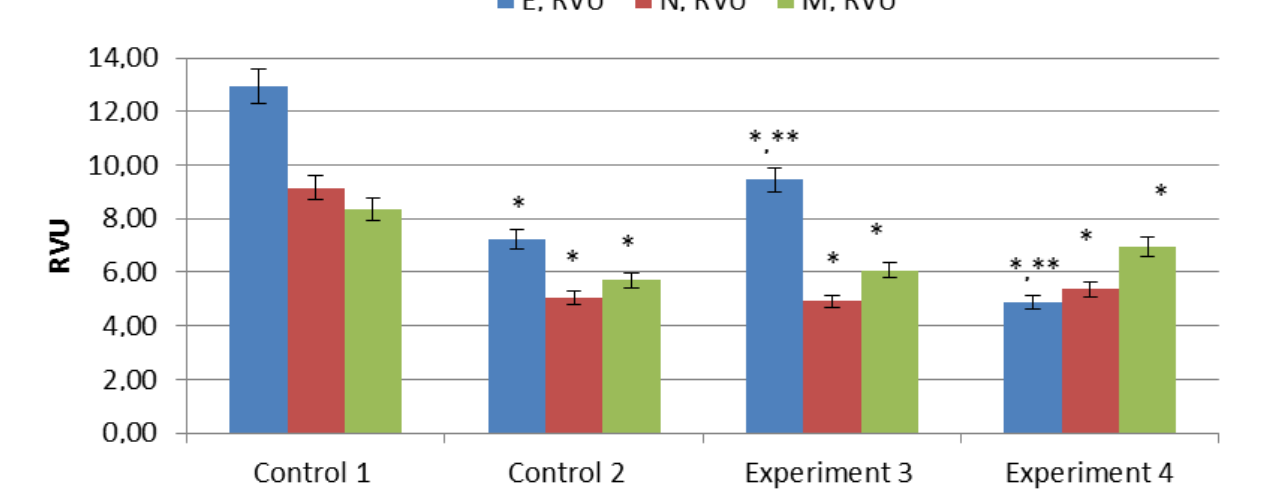
Figure 2. Dynamics of factors of active regulation of microcirculation under the influence of different EMR ranges of MM and subMM on animals in the CThB state. Note: E — endothelial factor, M — myogenic factor, N — neurogenic factor, * — differences are statistically significant compared to intact rats ( p < 0.05); ** — differences are statistically significant compared to CThB controls ( p < 0.05).